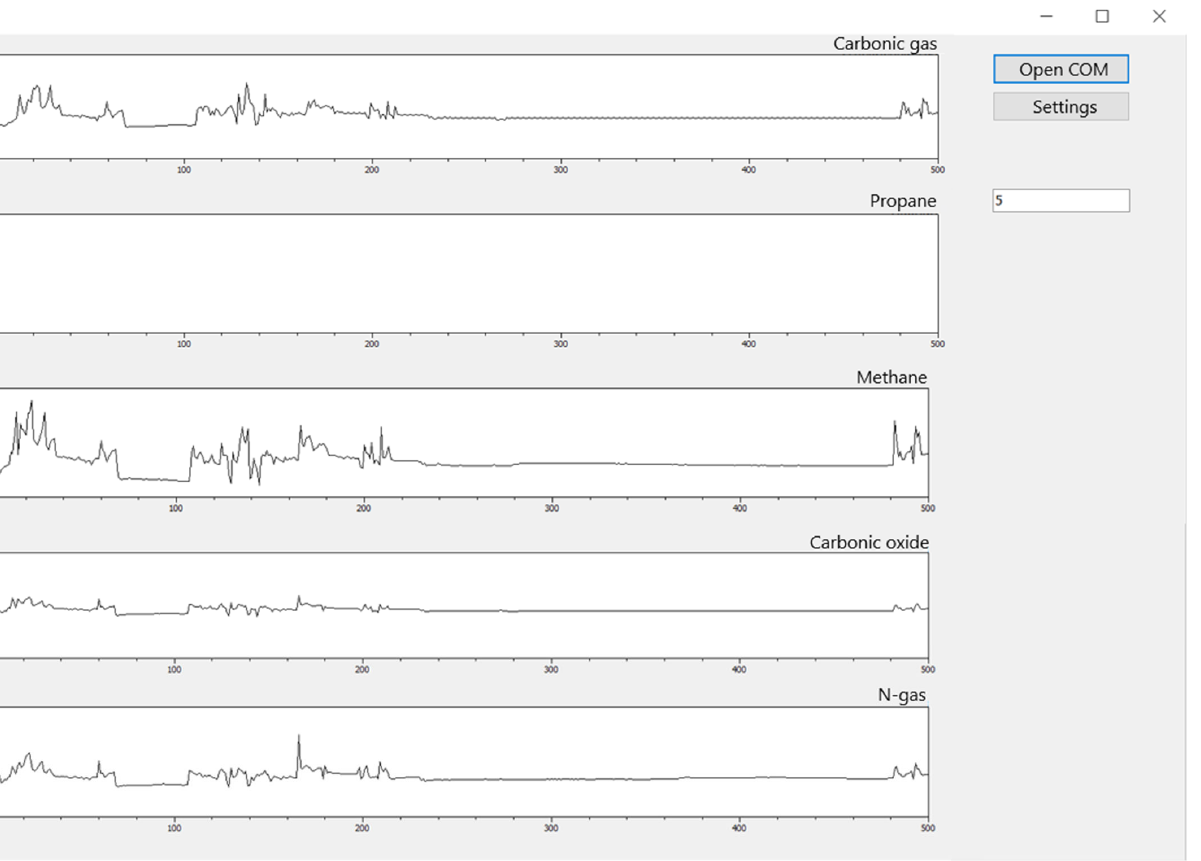
Figure 4. Monitoring system prototype interface.